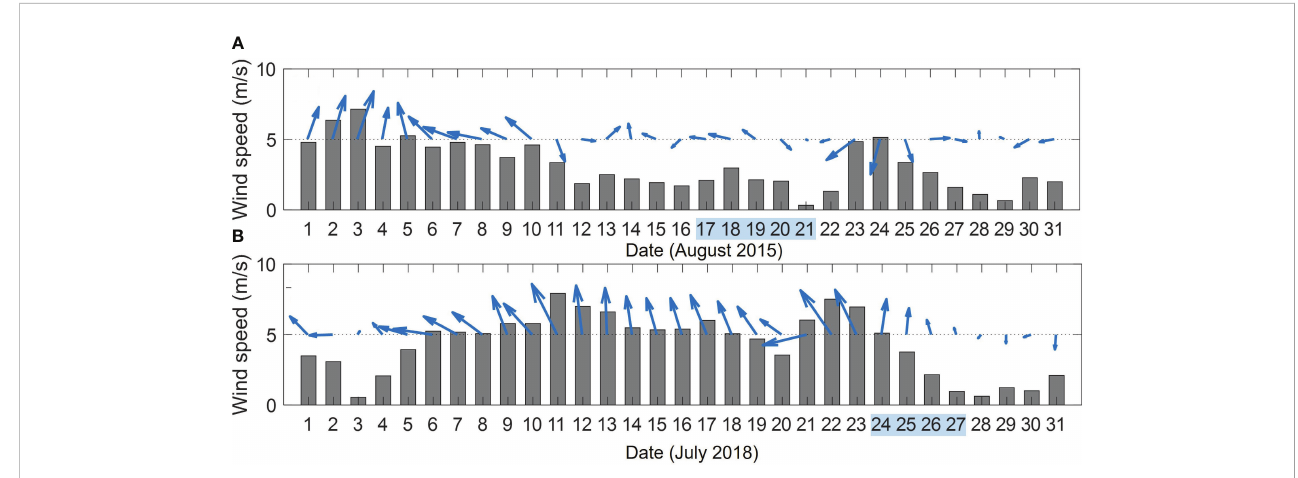
FIGURE 2 Daily mean winds in the southwestern Yellow Sea during the two fi eld surveys ( A : August 2015; B : July 2018). The gray bars and the blue arrows denote the wind speed and wind direction, respectively. The blue shadings in the horizontal axis denote the date of the